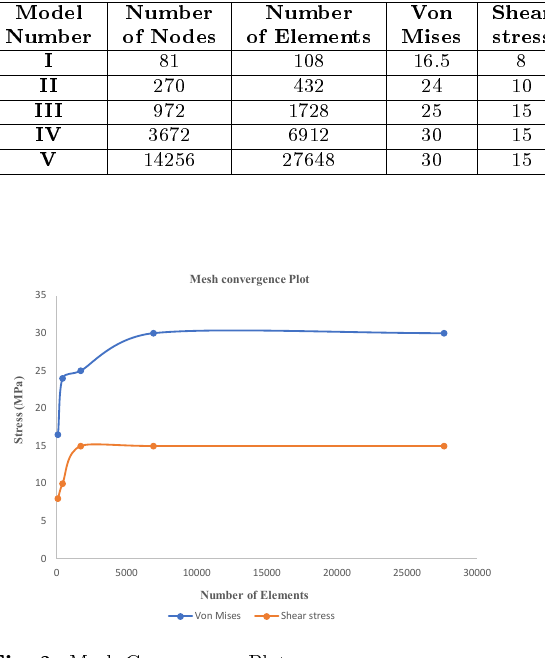
Fig. 3: Mesh Convergence